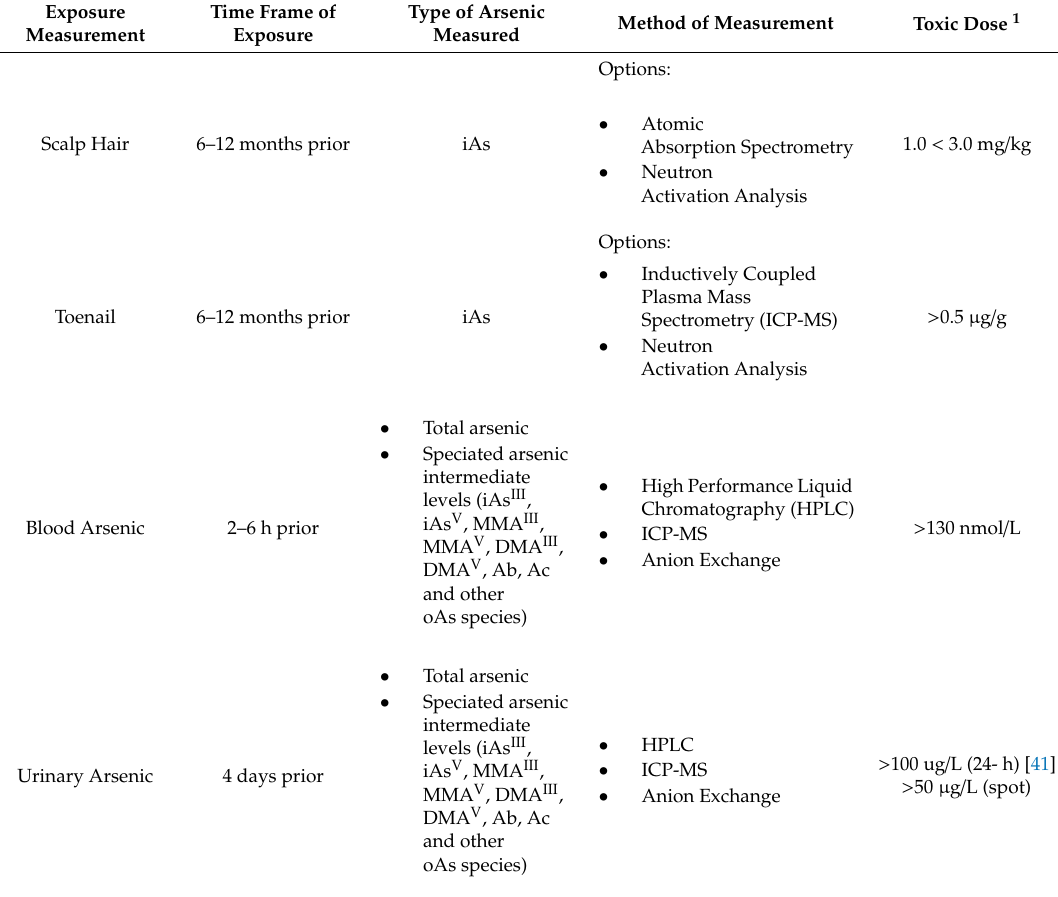
Table 1. Overview of biomarkers of arsenic